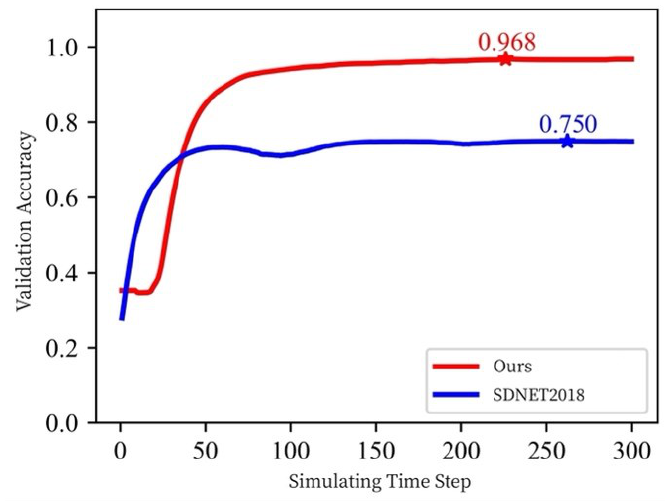
Figure 9. The validation accuracy of Converted VGG7 at different simulating time step.